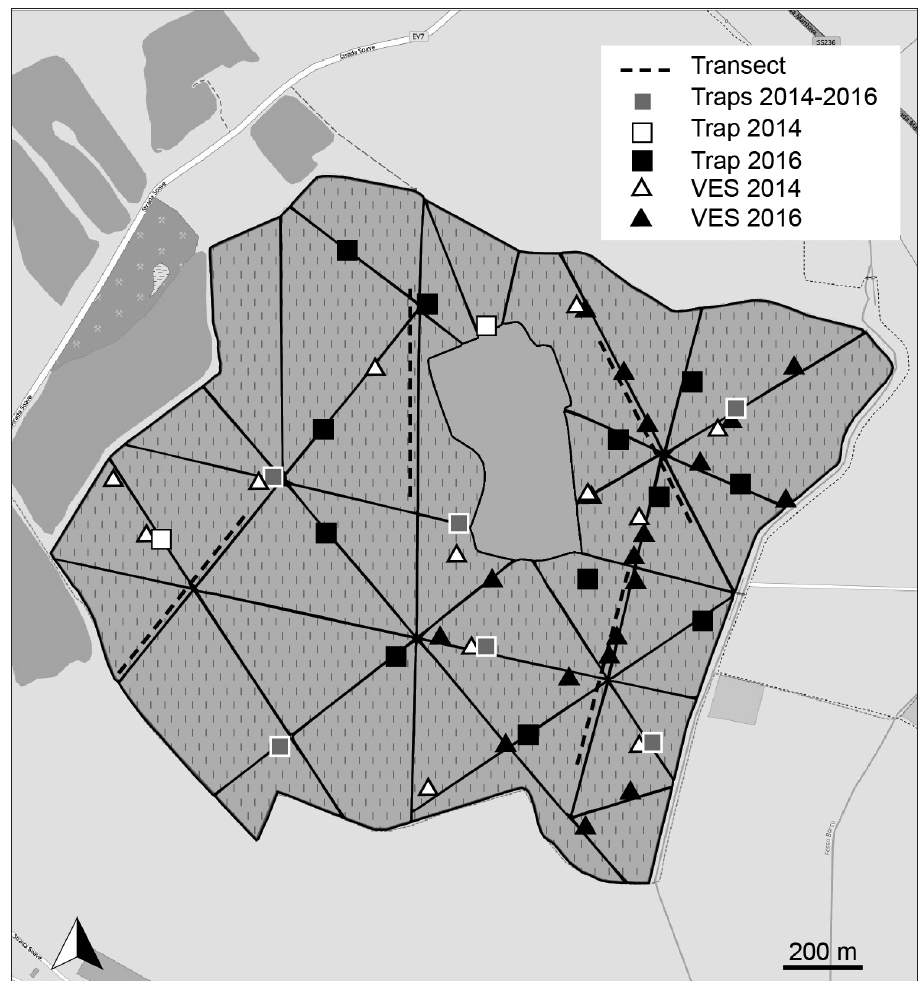
Figure 6. Map of the study area Bosco della